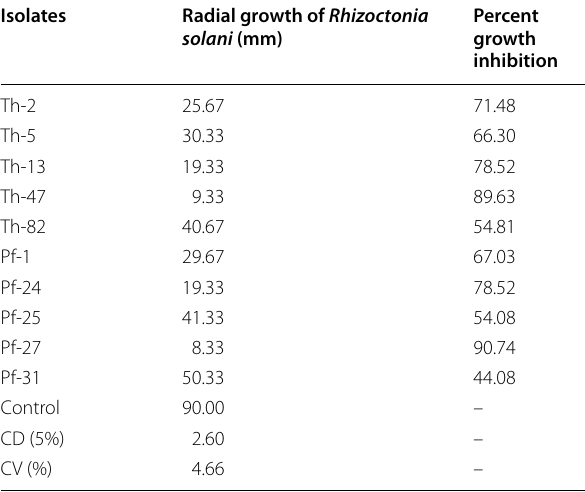
Th Trichoderma harzianum , Pf Pseudomonas fluorescens